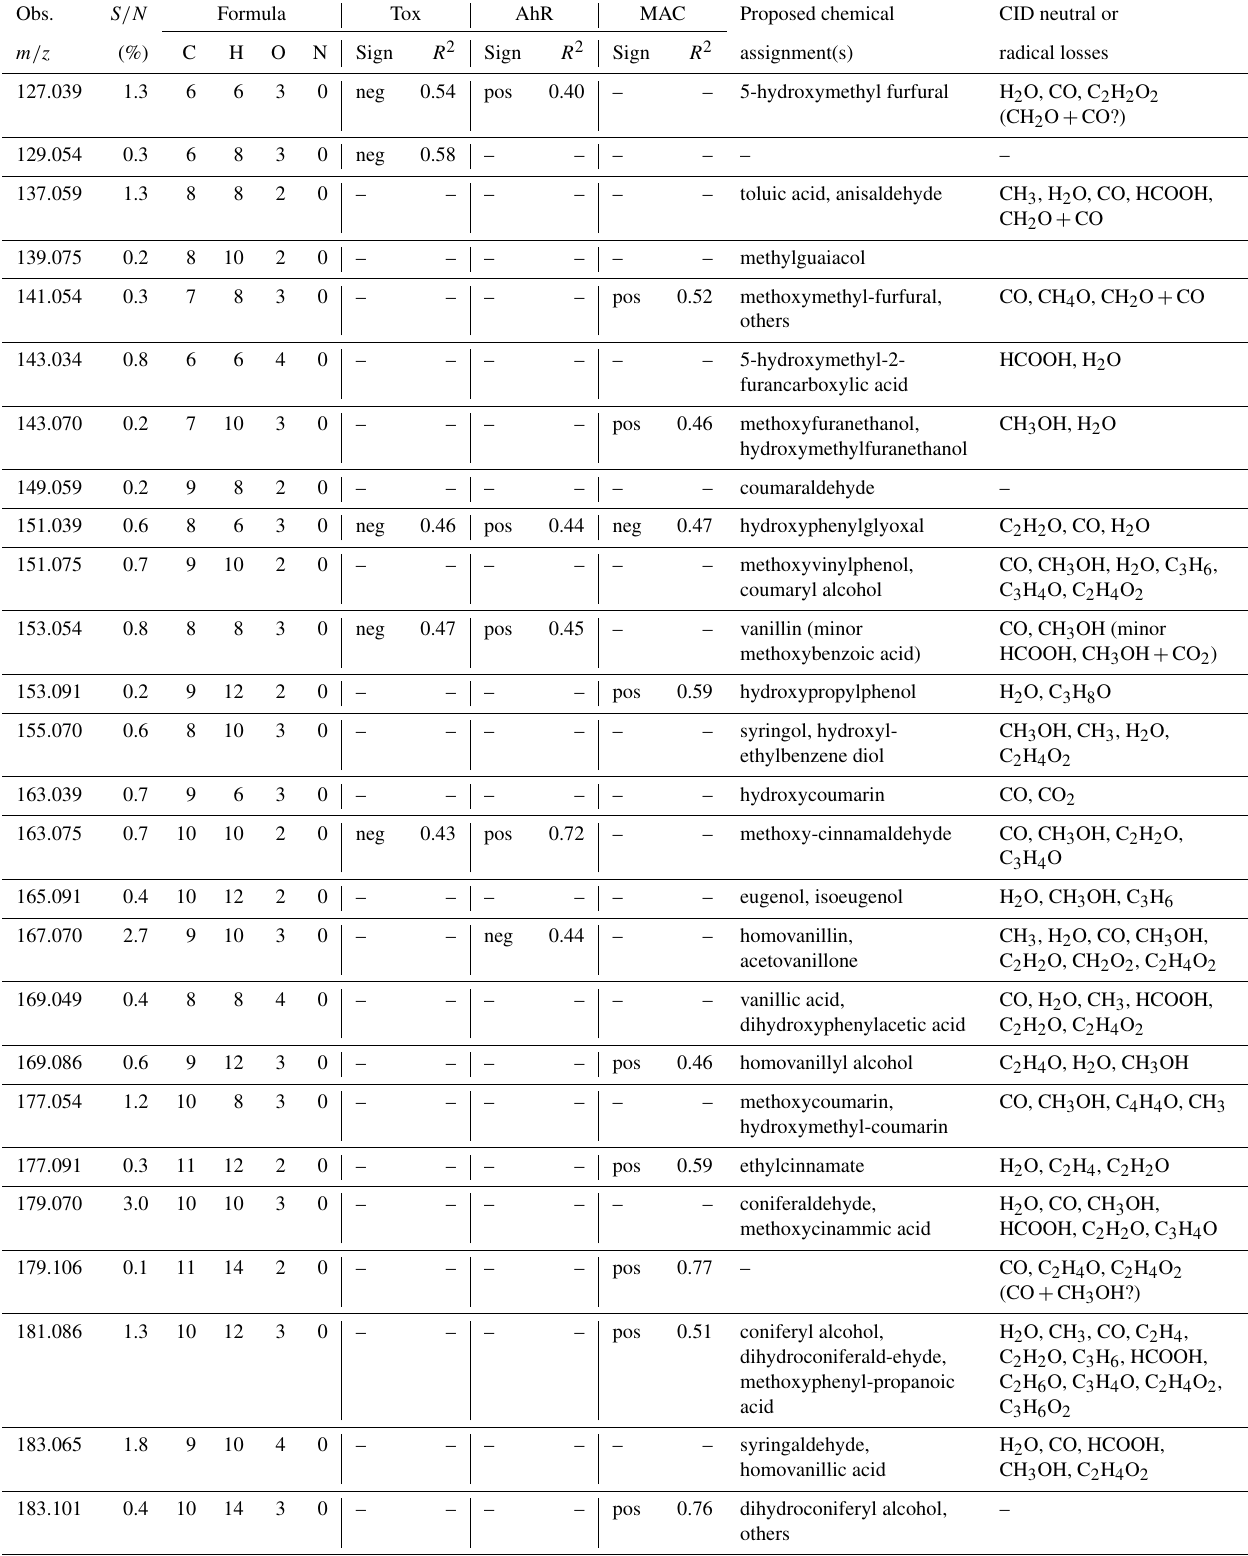
Table 2. Peaks observed in at least eight out of nine samples with either correlations with aerosol properties or other significance (e.g., high signals). The average normalized signal-to-noise ratios in all samples and the neutral molecular formulas are shown. Entries have p values ≤ 0 . 05 (90%), or p < 0 . 1